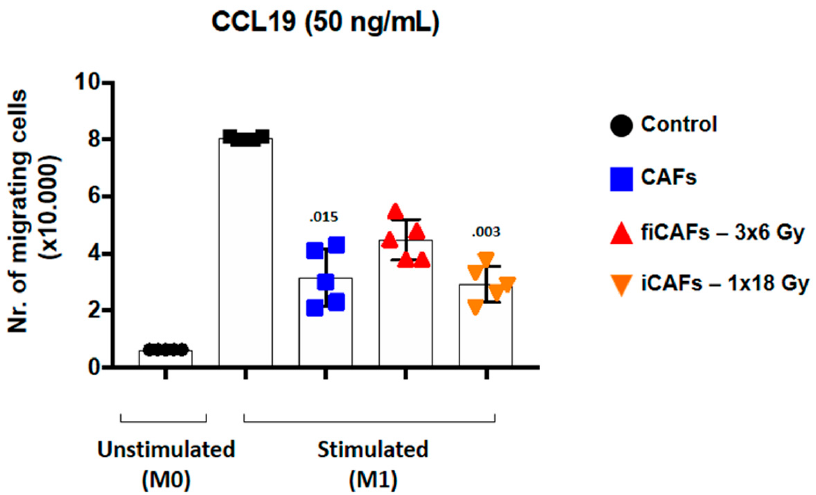
Figure 6. CAF-mediated effects on macrophage migration. For the Transwell migration assays, stimulated macrophages were initially incubated (48 h) with CM from irradiated or non-irradiated CAFs before seeding onto the insert membrane. The migration index was determined by counting transmigrated cells towards CCL19, which was added to the lower chamber. Non-parametric Kruskal-Wallis test and p -values were determined between control and non-irradiated CAF-CM, control and the two groups of iCAF-CM. Error bars indicate ± SD of five different CAF donors from triplicate determinations.